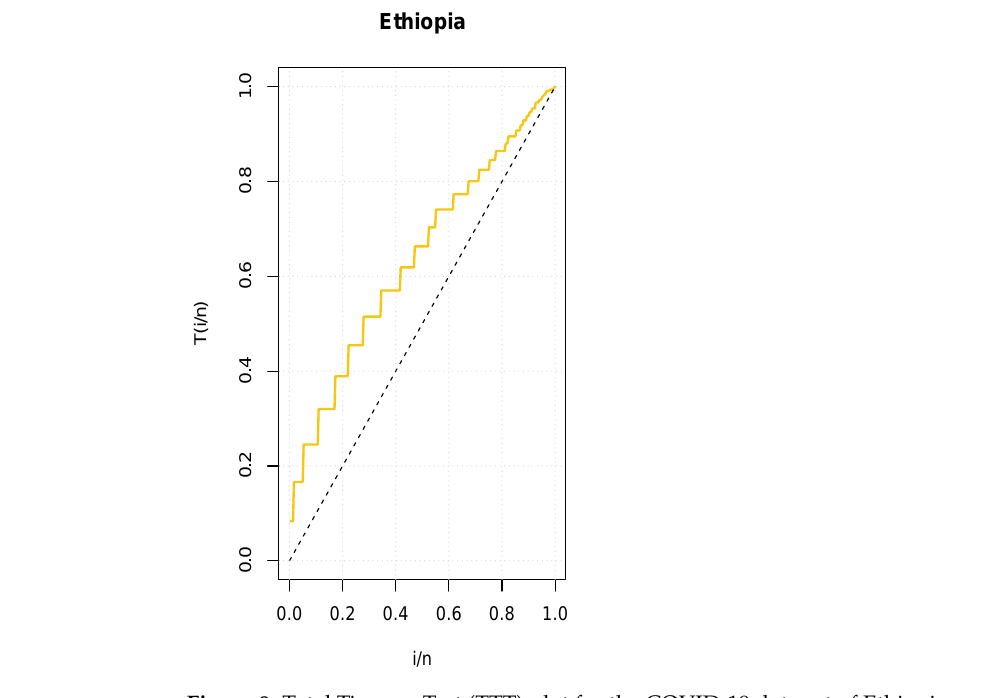
Figure 8. Total Time on Test (TTT) plot for the COVID-19 data set of Ethiopia.